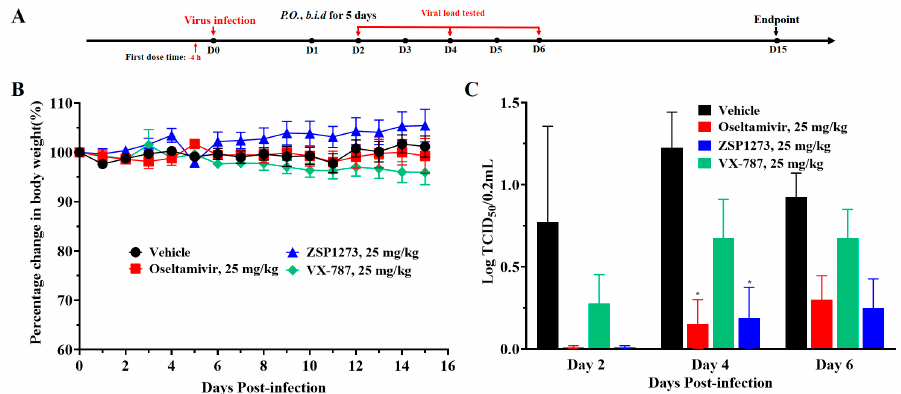
Figure 9. The antiviral activity of ZSP1273 in the ferret infection model (mean ± SEM): ( A ) Flowchart of the experiments: the day of H1N1 infection is defined as day 0, the first day after infection is denoted as day 1, and so forth. ( B ) Body weight changes of ferrets in each group with H1N1 infection after treatment. ( C ) Effects of oral administration of ZSP1273 on the viral load in nasal lavage fluid in the ferret influenza model. The statistical comparisons between each group and the vehicle group were performed by two-way ANOVA, with p < 0.05 indicating significant differences; * p < 0.05 (vs. vehicle); error bars represent the standard error of the mean value.